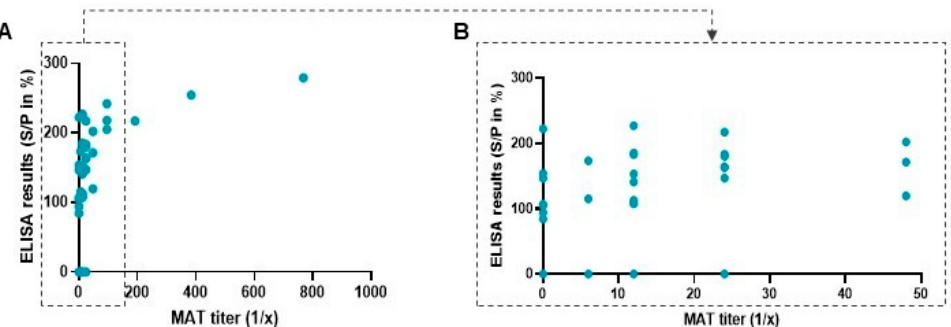
Figure 2. ELISA and MAT results for all dog sera tested. ( A ) Results of the 91 tested samples. ( B ) Zoom on the low MAT titer samples (between 1/6 and 1/48). Table 1. Contingency table for detection of T. gondii antibodies in sera of hunting dogs by commercial ELISA in comparison with MAT (n = 91).